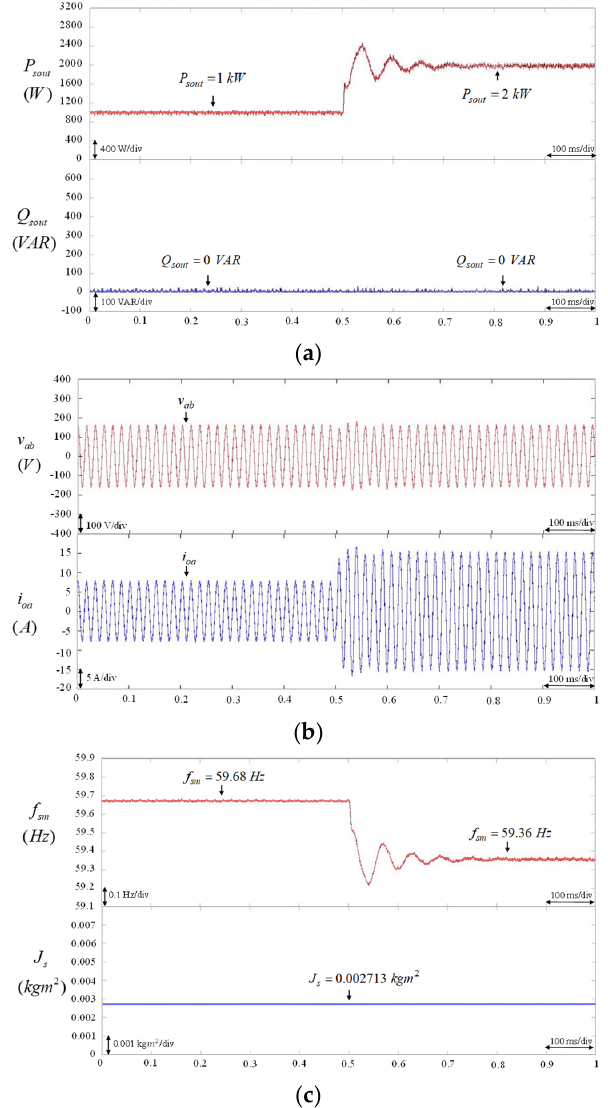
Figure 6. BESS using VSG control with constant virtual inertia J s = 0.002713 kgm 2 . ( a ) Responses of real power output P and reactive power output Q of BESS. ( b ) Responses of line-to-line voltage sout sout and output current i oa of BESS. ( c ) Responses of virtual rotor frequency f sm of VSG control and v ab virtual inertia J s